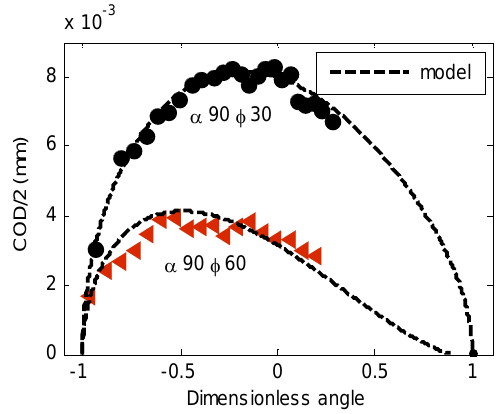
Figure 8: t= 2 mm crack length 2  (  0°) and (  0°).